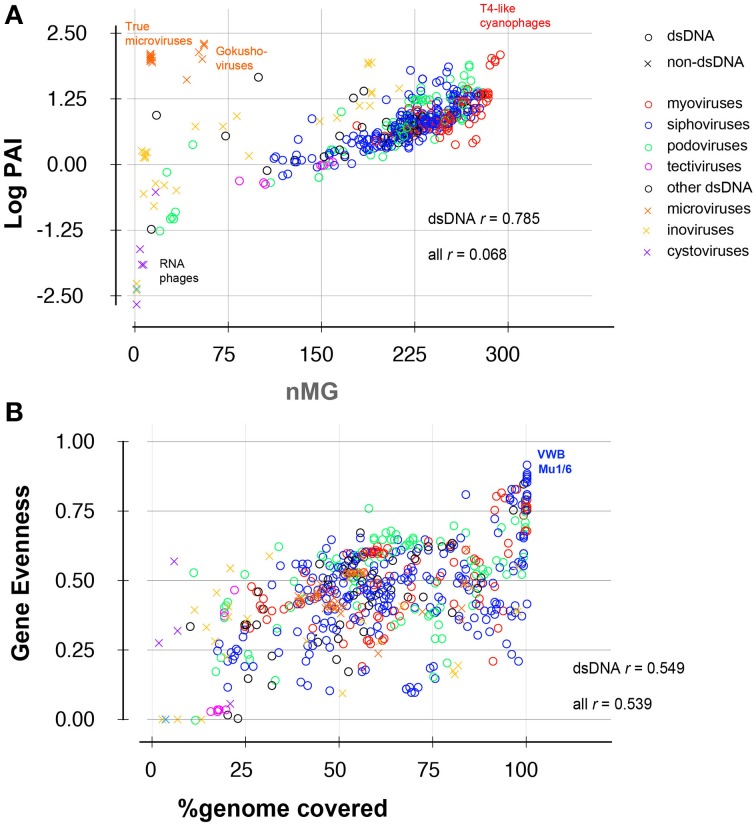
Scatter plots showing correlation between (A) abundance and ubiquity or (B) gene evenness and % genome coverage of 588 viruses in 296 metagenomes. Data points are labeled according to phage family (different colors), and nucleic acid content (circles: dsDNA phages; crosses: other phages, i.e., ssRNA, dsRNA, and ssDNA phages). Correlation coefficients (r) are shown for all phages and for dsDNA phages alone.